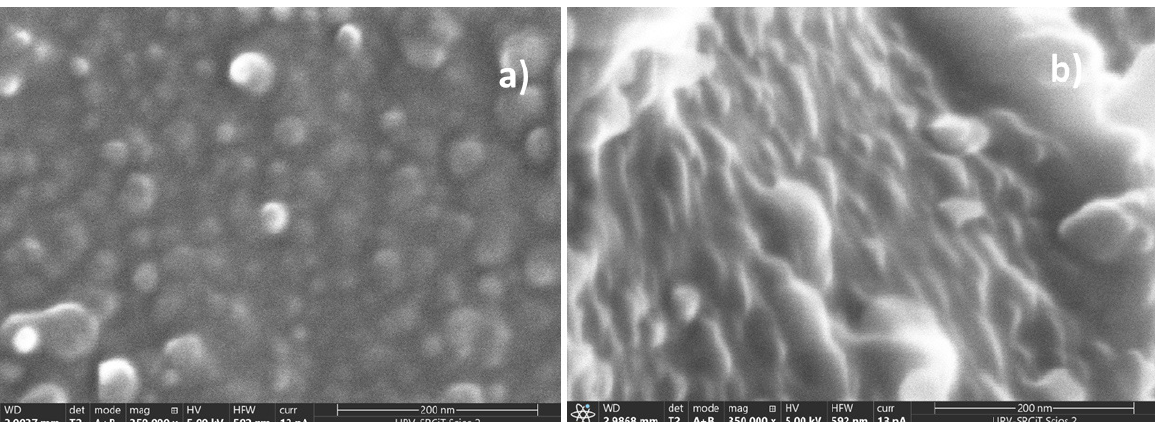
Figure 4. FESEM image of the scratched surface of CP40 oriented membrane. Left: membrane sur- face with scratched portion; Right: zoom of the scratched